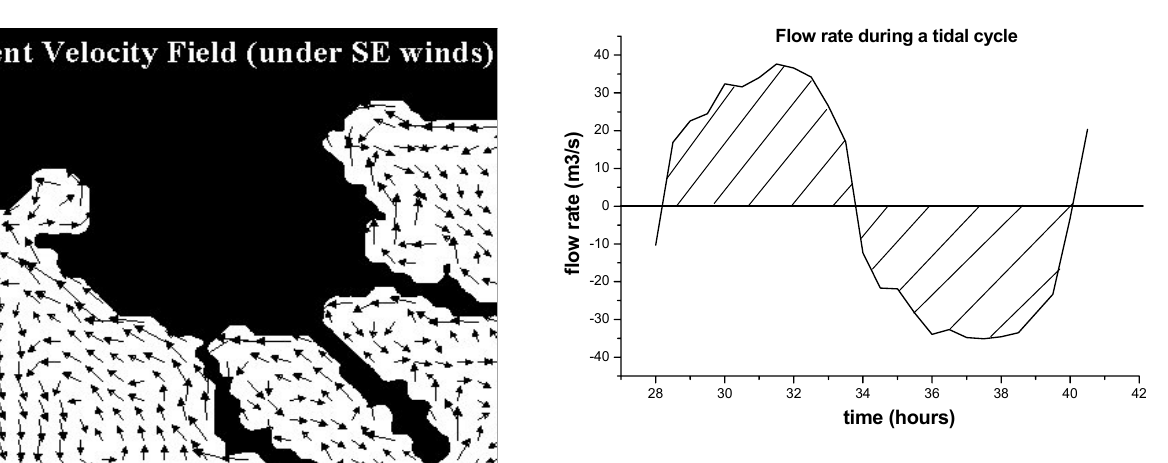
Fig. 10. Flow rate in the channel during a tidal cycle (the time is Fig. 10 Flow rate in the channel during a tidal cycle (the time is from the start of simulation) from the start of